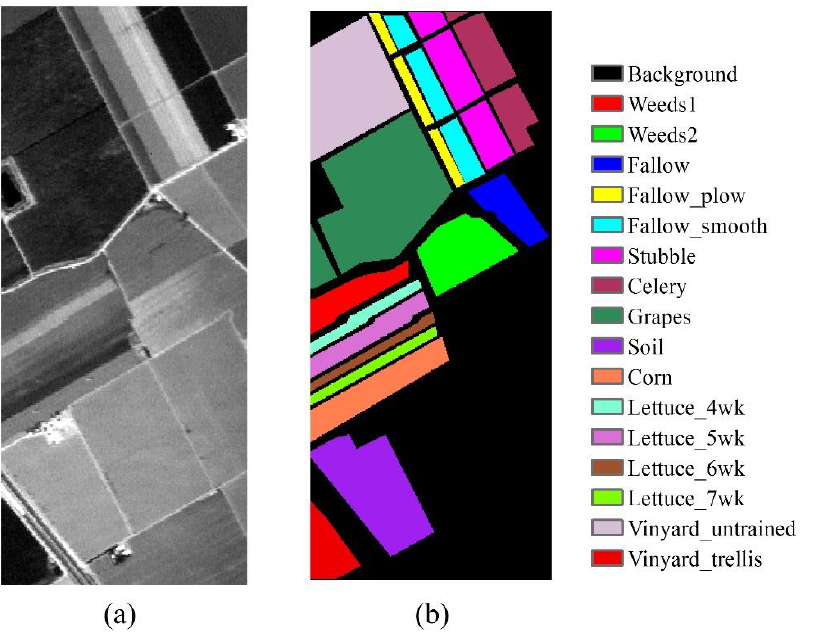
Figure 5. Salinas ( a ) sample band (band 5) and ( b ) ground truth image.